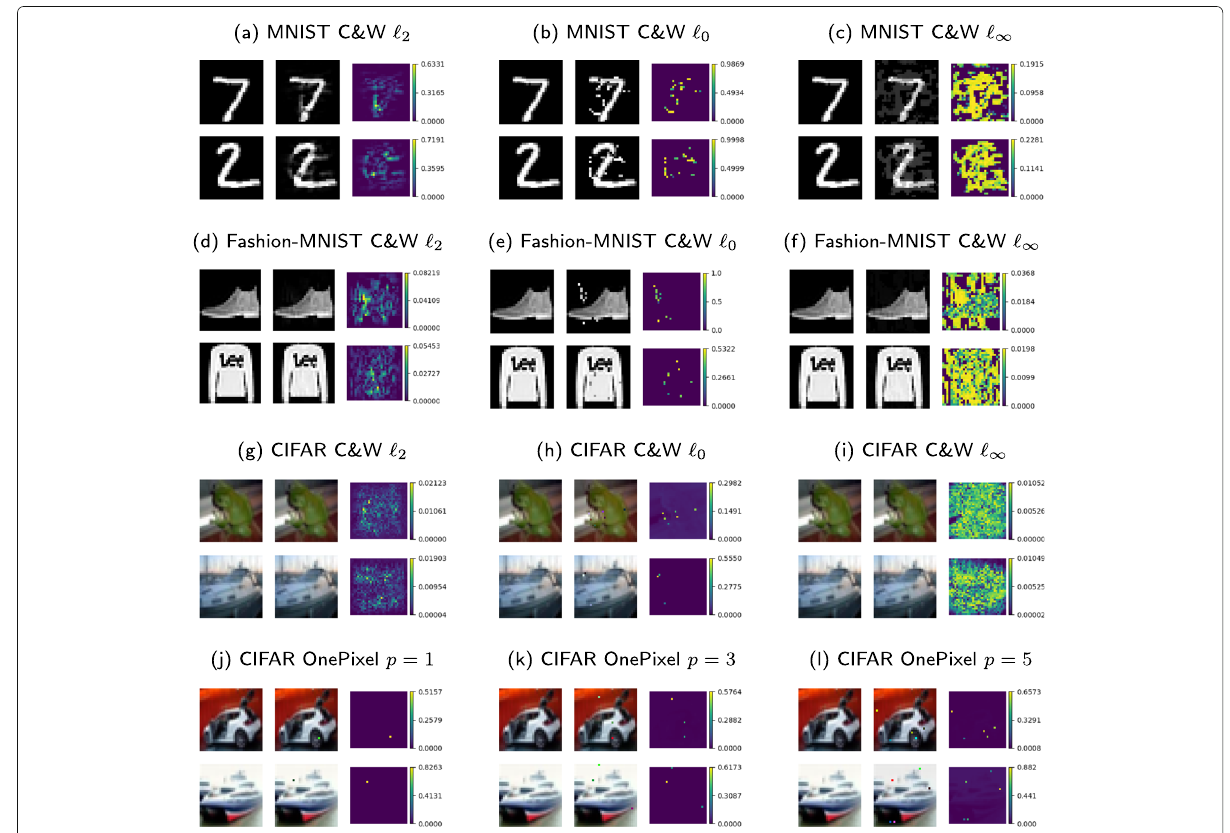
Fig. 11 Adversarial examples: (left) original image x , (middle) adversarial example x adv , and (right) absolute value of the adversarial perturbation (cid:3) computed as | (cid:3) | = | x − x advv